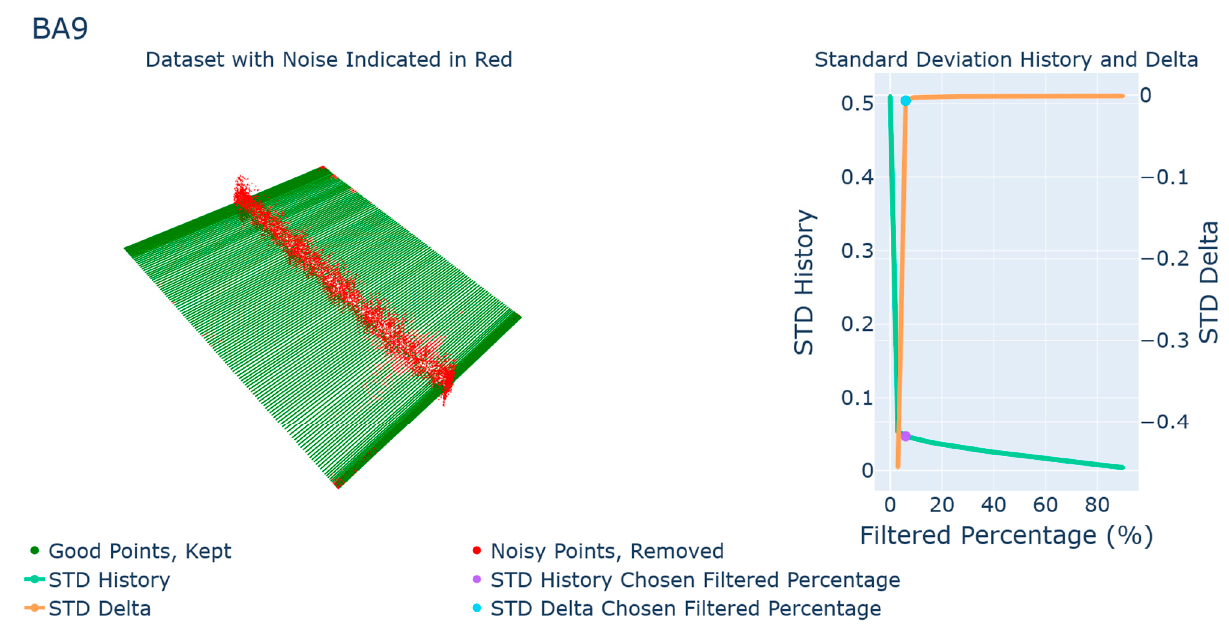
Figure 7. Results for brushed aluminum at +15° with STD history and delta graphs combined.